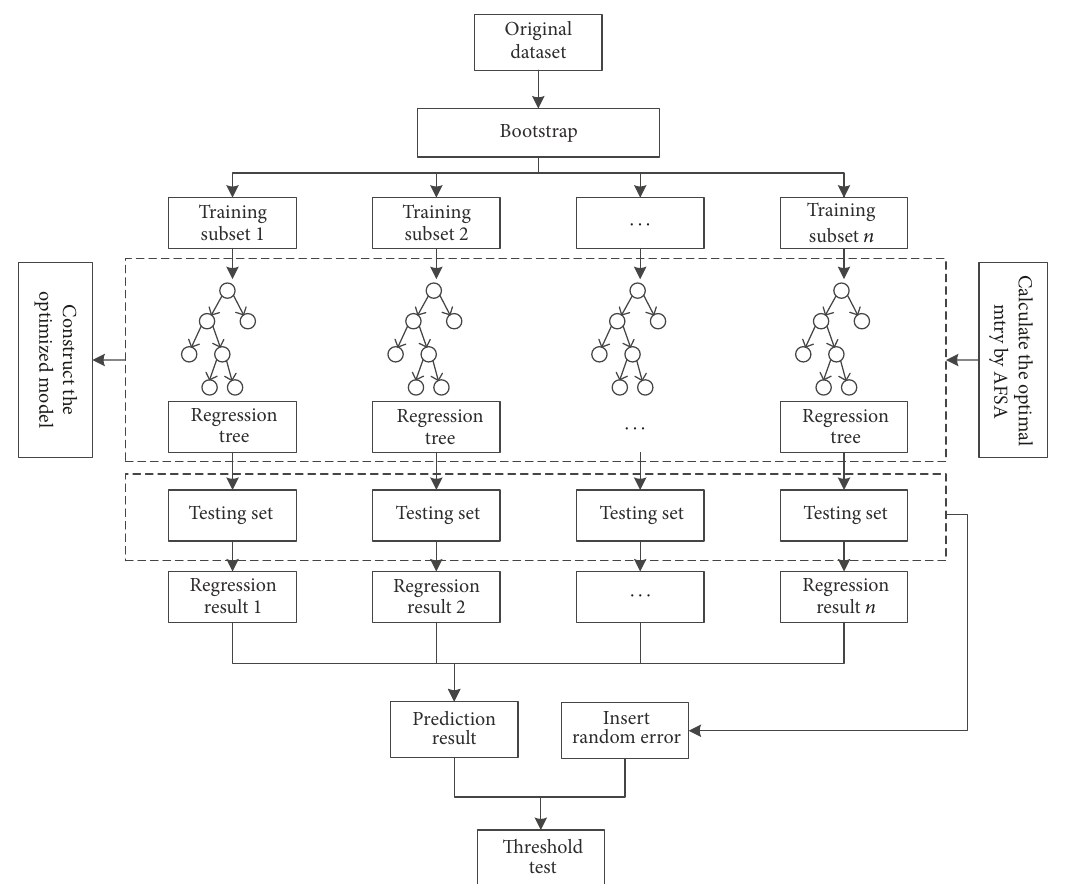
Figure 3: Flowchart of the QC modeling procedure